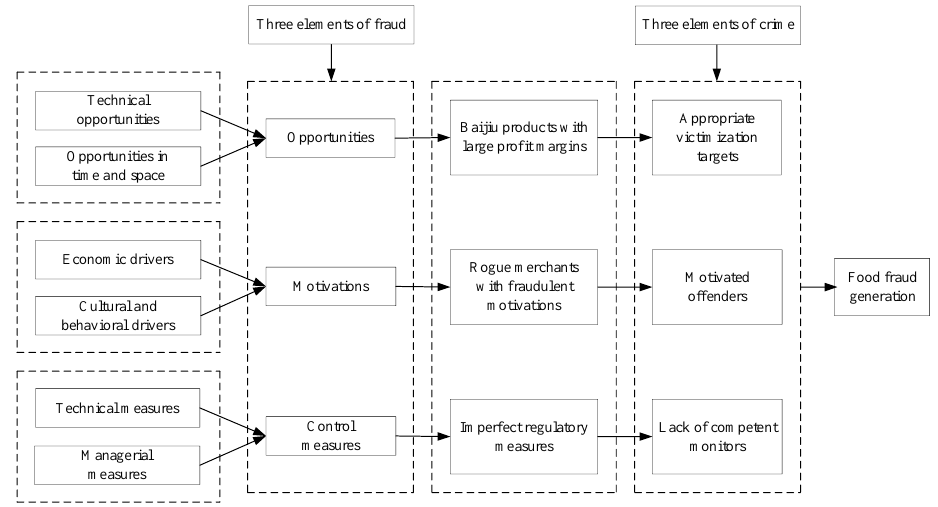
Figure 1. Theoretical framework chart.